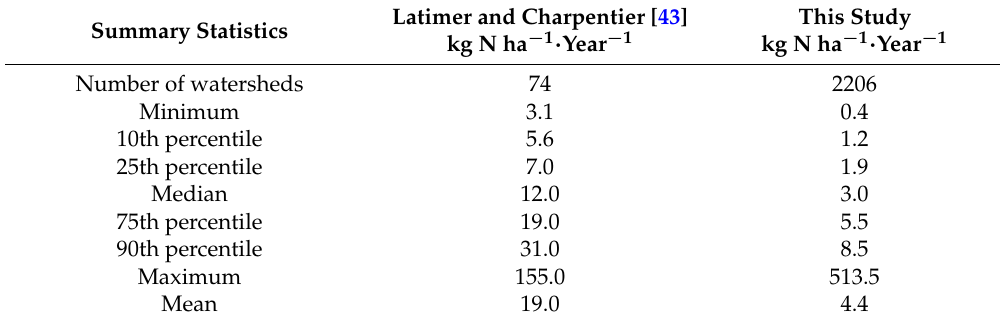
Figure 4. Median land use distribution across 2206 N removal dams draining to the Atlantic from New England.